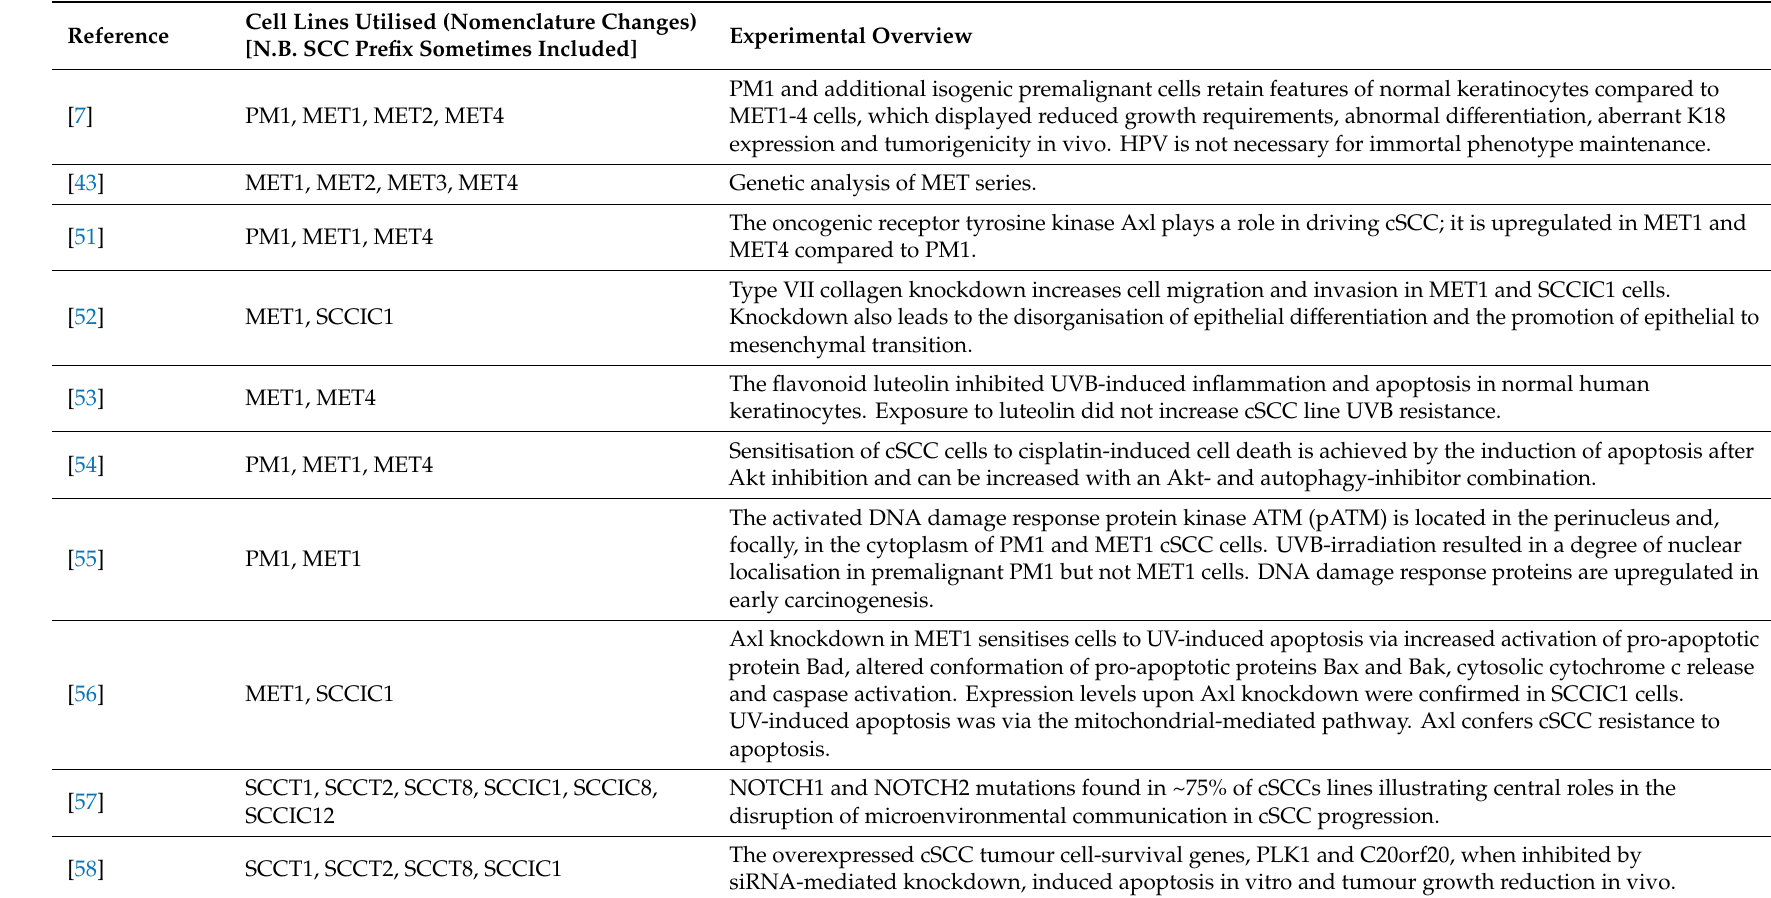
Table A1. Summary of previous publications using recently fully characterised cSCC